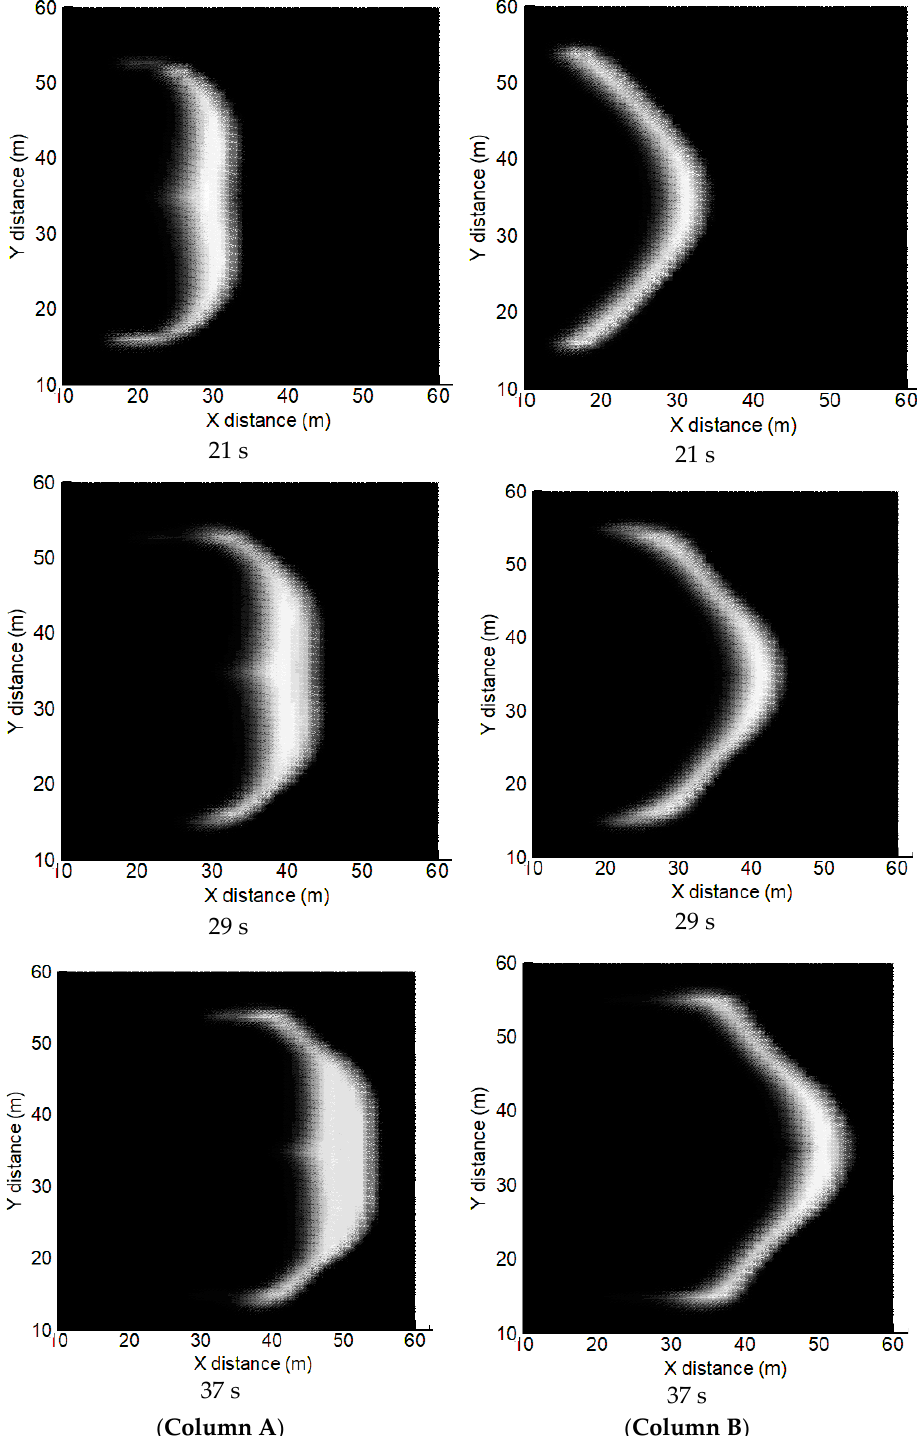
Figure 5. Fire contour at different times marked by temperatures above 500 K: ( Column A ) edge-to- centre ignition; ( Column B ) centre-to-edge ignition.